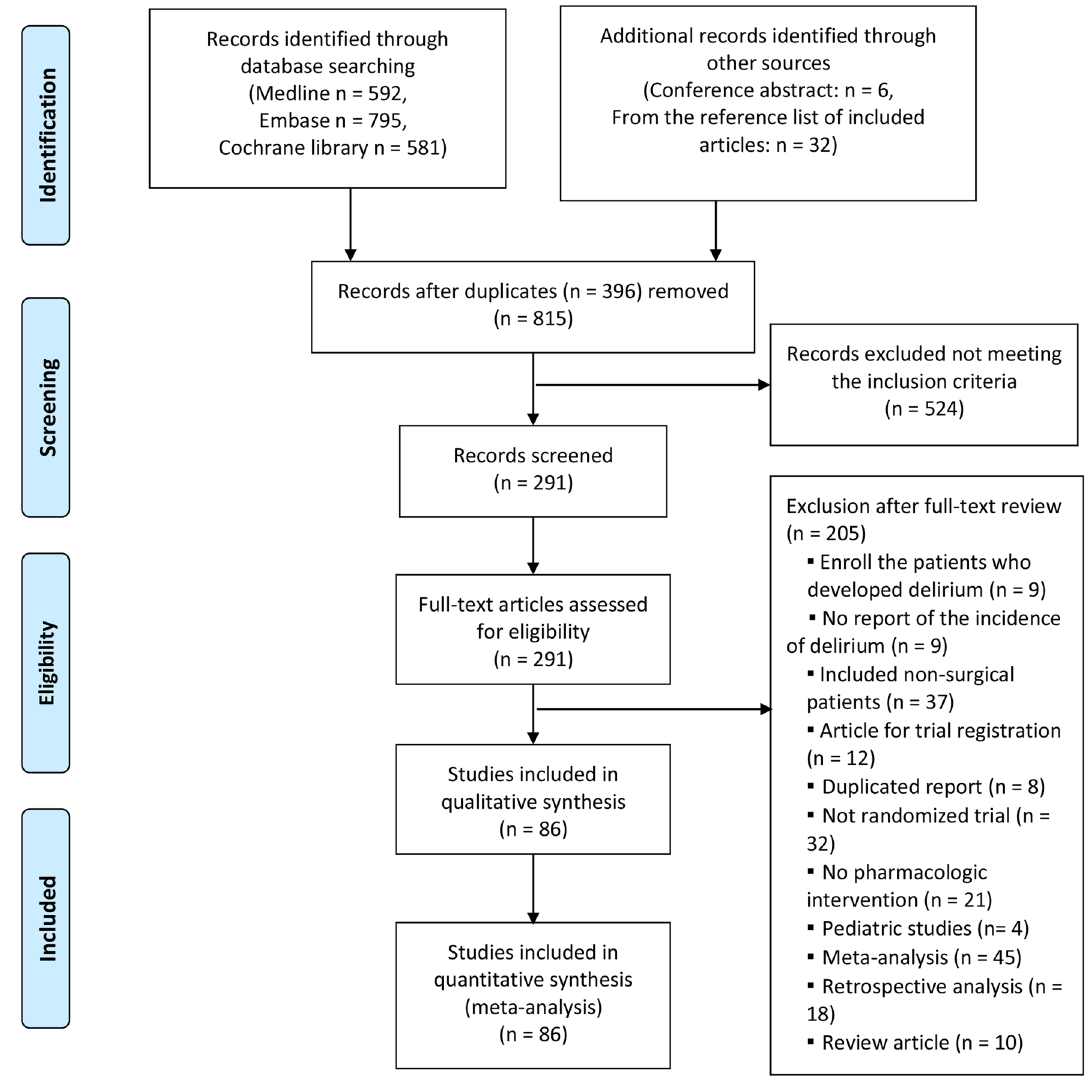
Figure 1. Flow diagram of our network